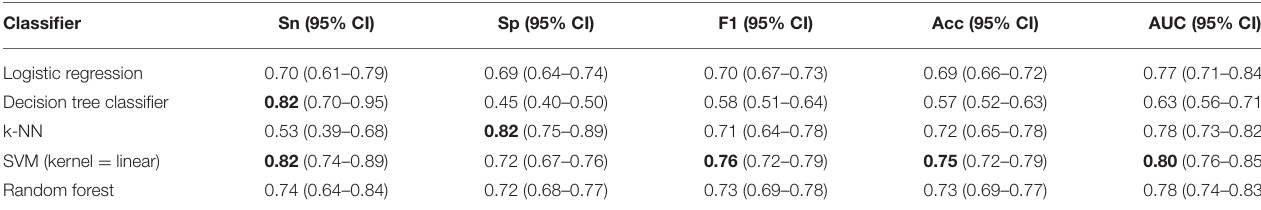
FIGURE 2 | Explaining an individual model prediction for three different TigerPlace residents. The explanation in these plots shows predictors each contributing to push the model output from the base value (the average model output over the training dataset we passed) to the model output for an individual resident. Predictors pushing the prediction higher are shown in red, those pushing the prediction lower are in blue. (A) Model prediction explanation for resident 1. (B) Model prediction explanation for resident 2. (C) Model prediction explanation for resident 3. TABLE 4 | Classification results in predicting 6-month fall